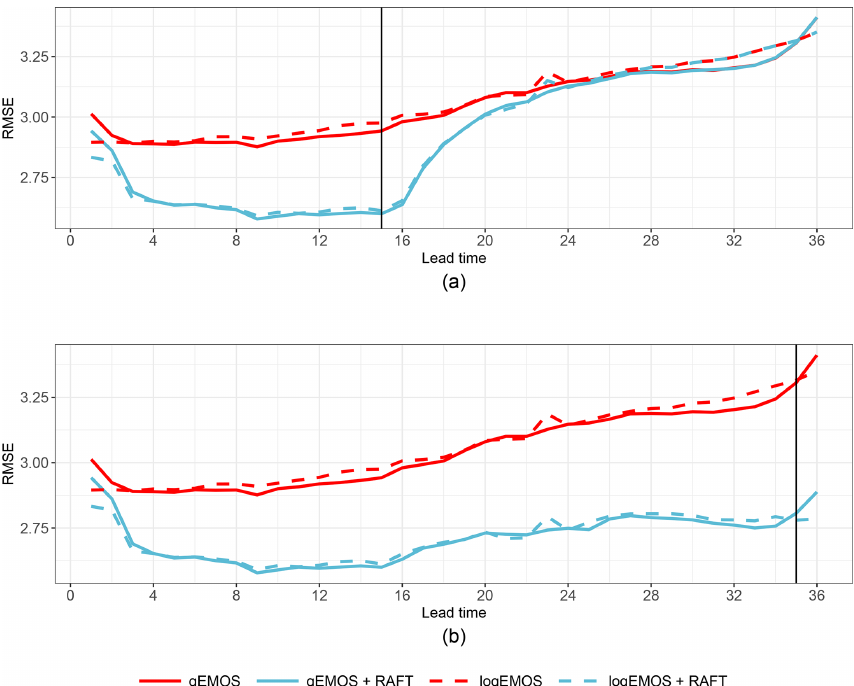
Figure 4. RMSE over lead time for gEMOS (red solid line) and logEMOS (red dashed line) mean forecasts, as well as their RAFT m adjustments (blue solid and blue dashed lines, respectively). The scores are averaged over all model runs and sites in the evaluation set. (a) RAFT is only carried out until the adjustment at t + 15. (b) RAFT is carried out until its last iteration at t + 35. Table 1. Univariate and multivariate mean scores for different post-processing method combinations, using the final RAFT adjustments 1h before valid time. Bold numbers denote the best score in each column. All score differences are significant at the 95% level, apart from the ones marked with an asterisk, where the pairwise differences between the versions using gEMOS and logEMOS are not significant. RMSE CRPS Euclidean error Energy score Variogram score Raw ensemble 3.670 2.116 19.207 15.132 847 gEMOS 3.056